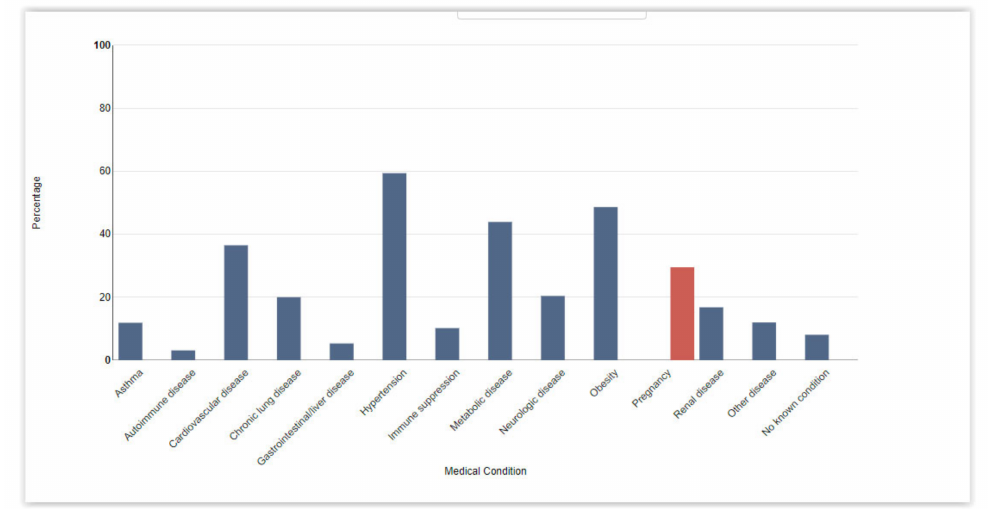
Figure 2. Underlying medical conditions and pregnancy by percentage in patients with COVID-19- related hospitalizations in the USA. Data are restricted to cases reported during 1 March 2020–31 March 2021, due to delays in